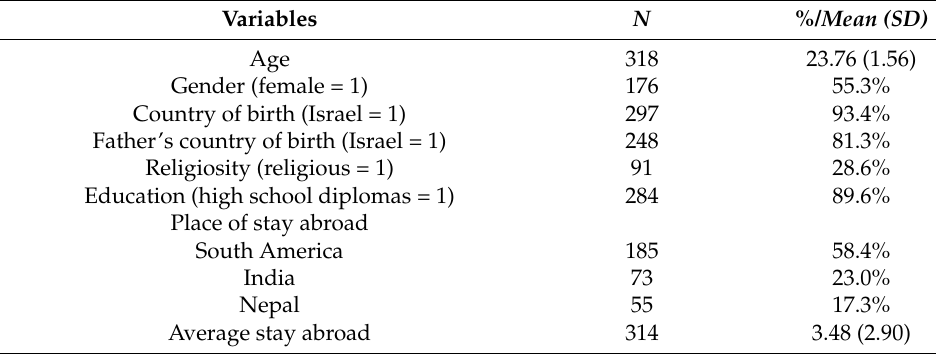
Table 1. Descriptive statistics of the sample ( N =